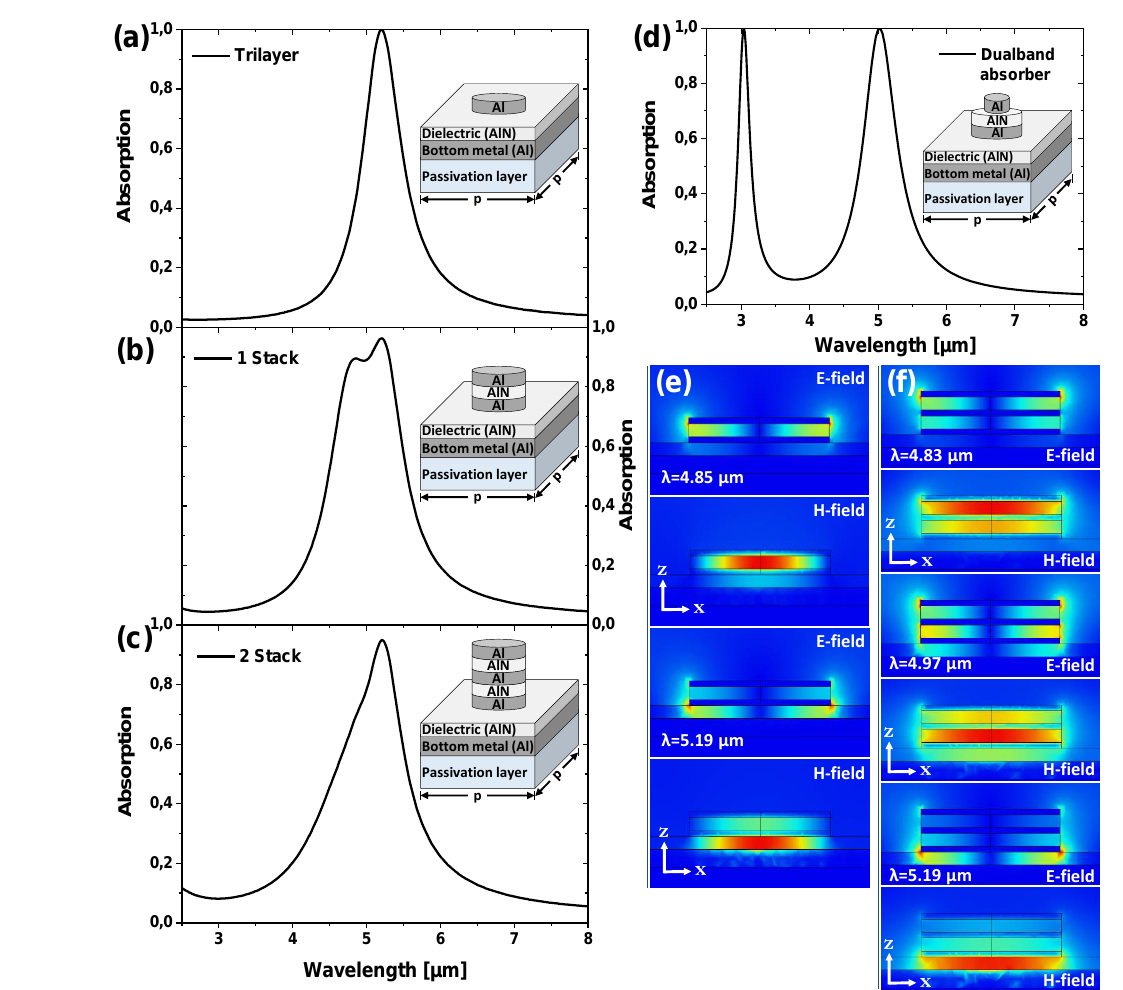
Figure 5. Multilayer absorption spectra for (a) trilayer, (b) one-stack, and (c) two-stack systems. (d) Dual-band absorber based on a modified one-stack absorber. All insets show the specific stack configurations. (e) and (f) represent the electric and magnetic field distribution in the absorber at different resonance wavelengths related to absorption spectra shown in (b) and (c) ,